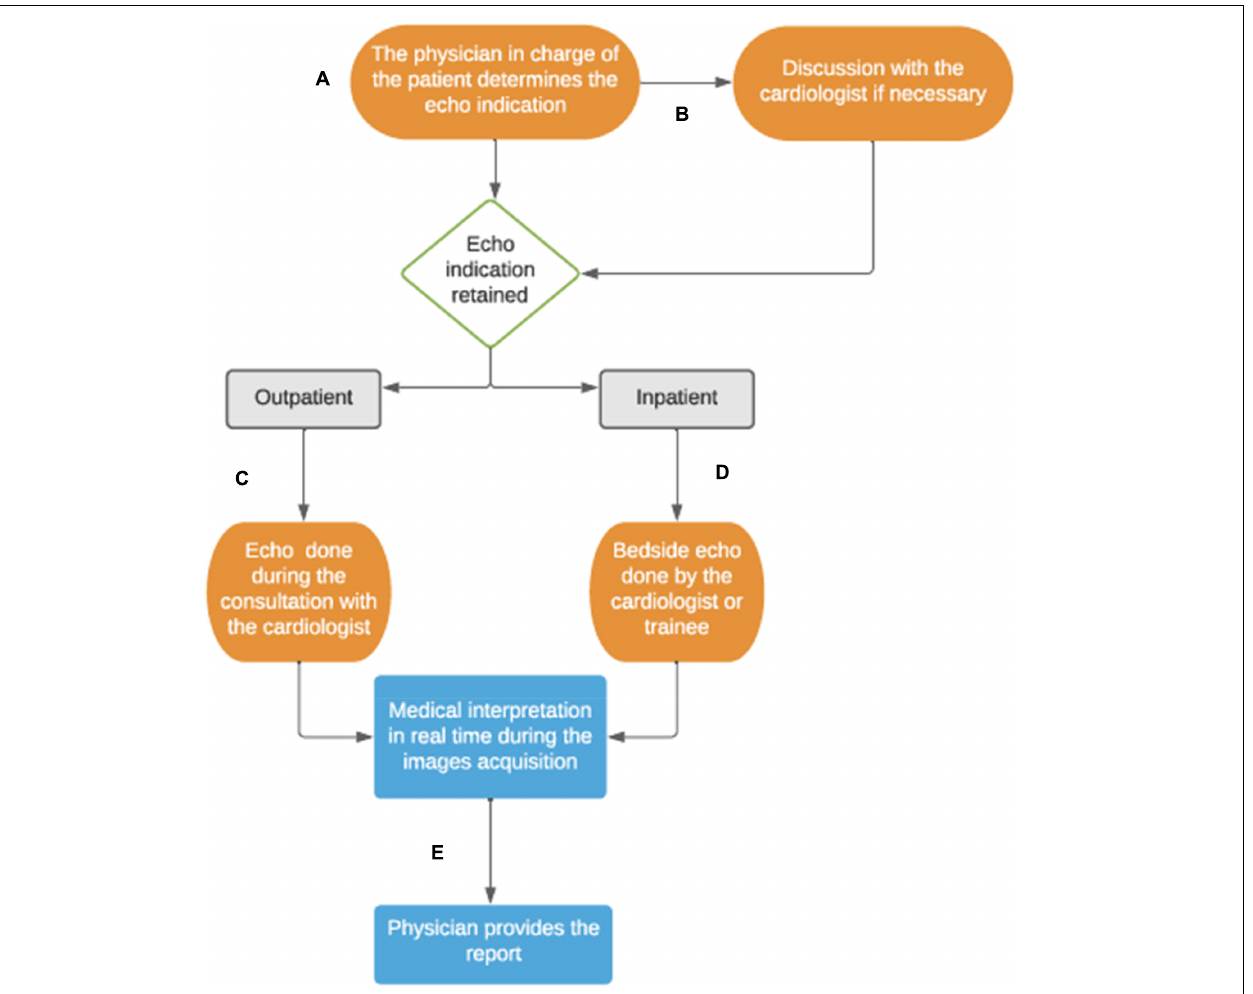
FIGURE 3 | Physician-based echocardiography system at the University Hospital of Bordeaux, France. (A) The physician assesses the echocardiogram indication for his patients. (B) If the physician is not a cardiologist, he usually discusses with the heart team to validate the indication. (C) For the outpatients followed up in cardiology clinic, the echocardiogram is done by the cardiologist during the consultation. (D) About inpatients, the inward cardiologist staff and trainees manage the TTE indication and scanning during the hospitalization. (E) The interpretation of the images is done in real time and the report is noted with the patient’s daily notes, or in the consultation letter for